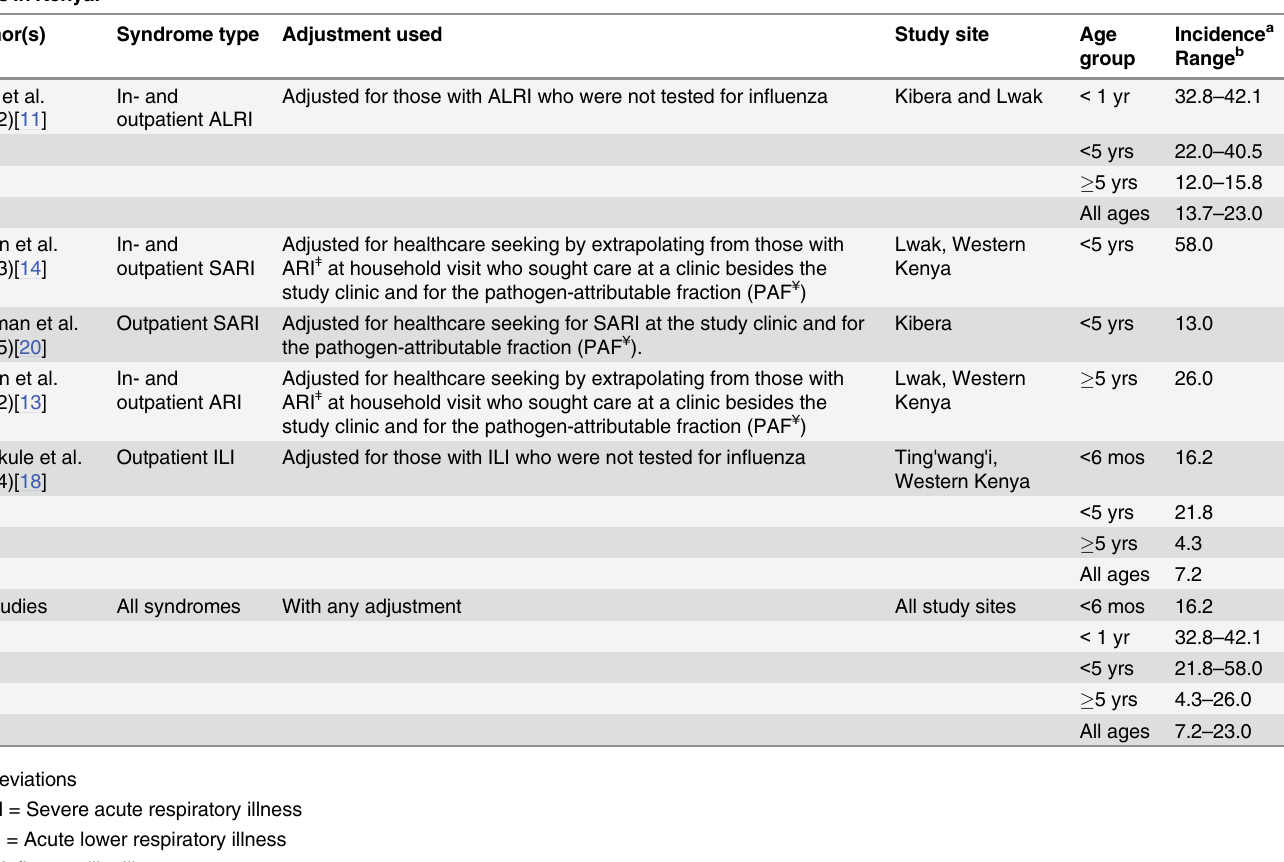
Table 2. Average annual incidence rates of medically-attended influenza A and/or B (hospitalized and outpatient) per 1,000 persons or person- years in